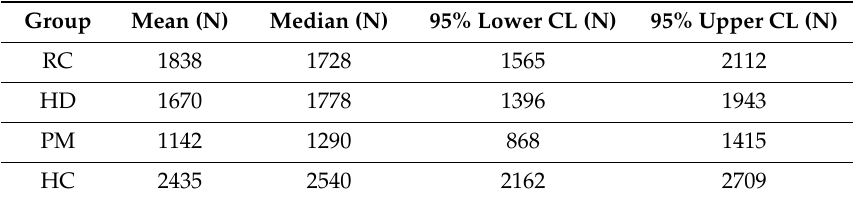
Table 3. Descriptive statistics.